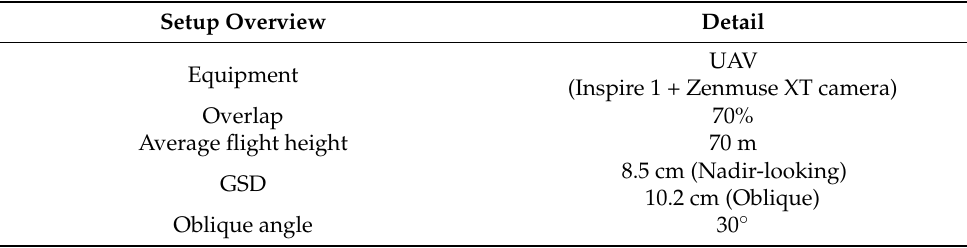
Table 2. Specification of the TIR image